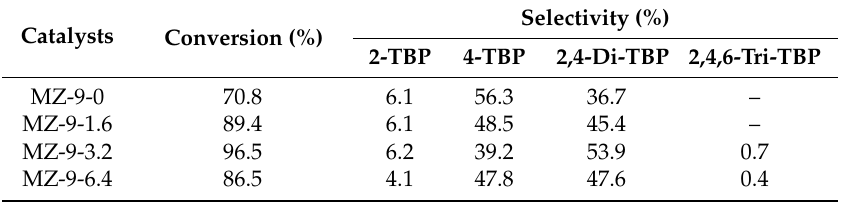
a Reaction conditions are the same as Table